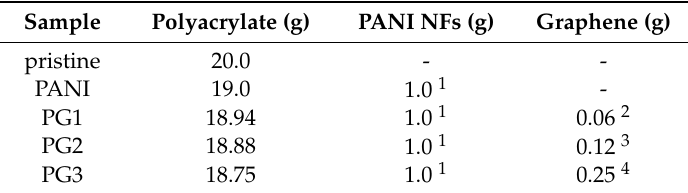
Table 1. Preparative conditions of polyacrylate resin